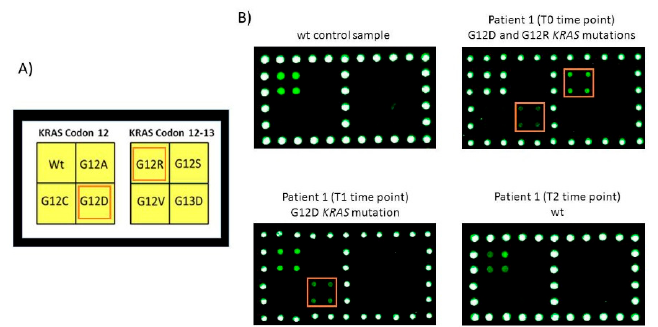
Figure 3. Analysis of ctDNA extracted from plasma of patient 1 at T0, T1 and T2 time points. ( A ) Spotting schema of the portion of the barcode probe array reported in Figure 2A corresponding to the barcode probes for KRAS codon 12 and 13. ( B ) Cy3 fluorescence images of the analysis of ctDNA extracted from a control wild-type plasma sample and from plasma of patient 1 at T0, T1 and T2 time points. The barcode probes corresponding to KRAS G12D and G12R are